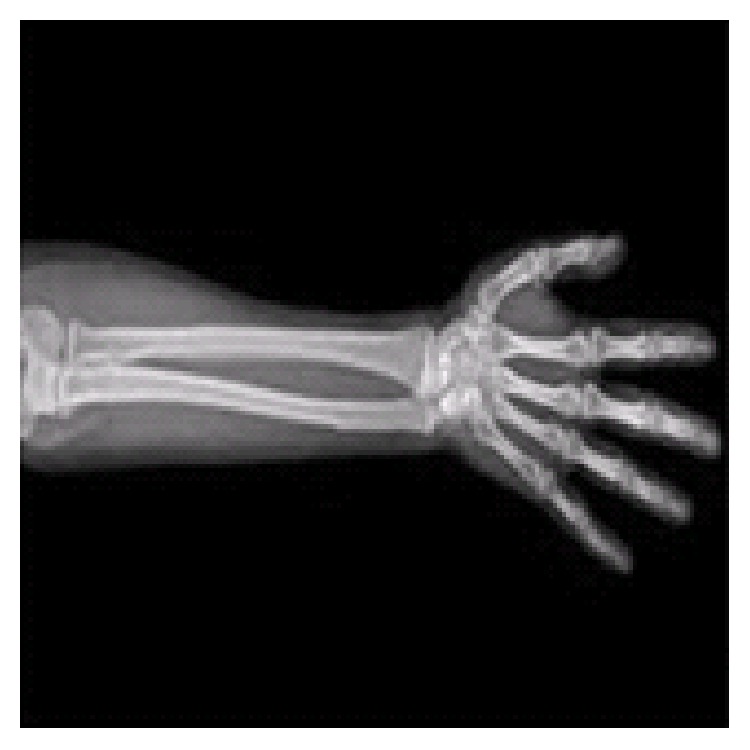
Watermarked image.